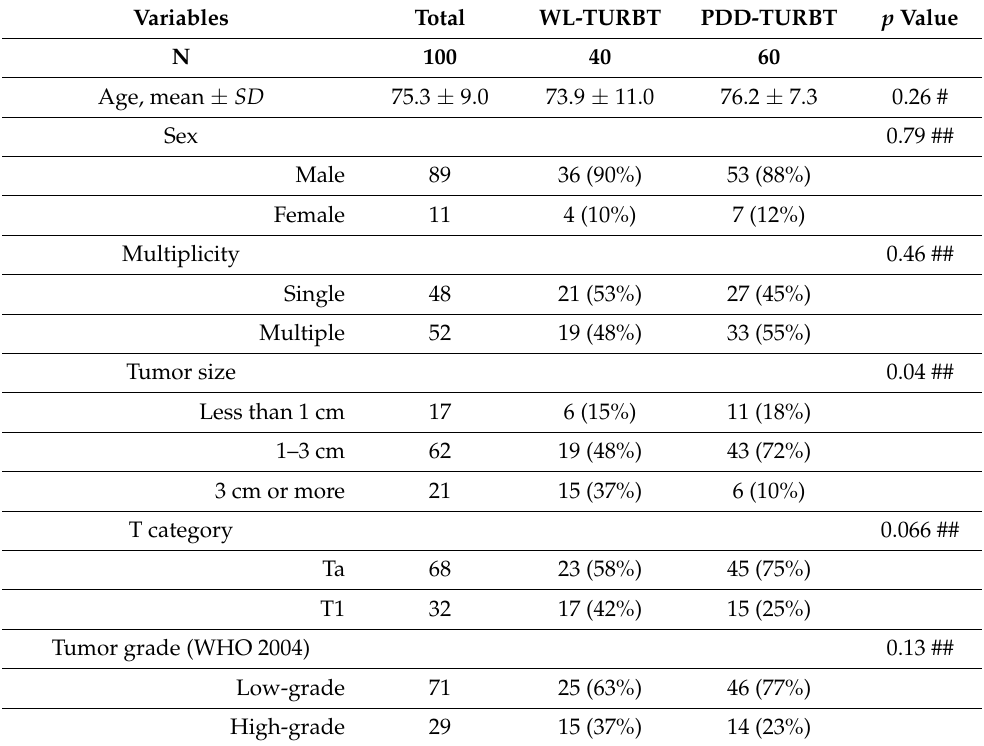
Figure 2. Study design and flow chart of this study. NMIBC: non-muscle-invasive bladder cancer; TURBT: transurethral resection of bladder tumor; BCG: Bacillus Calmette Gu é rin; WL: white-light; PDD: photodynamic diagnosis. Table 1. Clinicopathologic variables of patients treated with WL-TURBT or